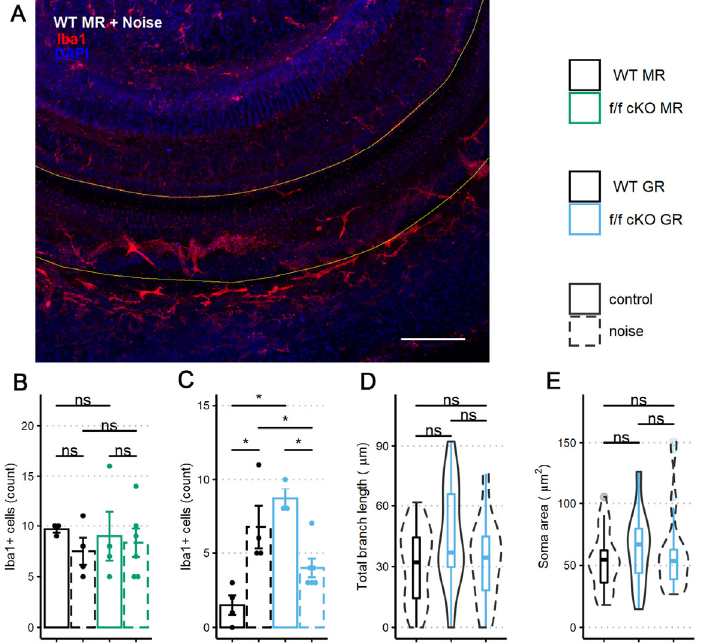
Figure 8. Iba1 + cells within the middle-turn sensory epithelium of mice at 7 dpn and from age-matched controls. ( A ) A representative image of a sensory epithelium wholemount prep from a noise-exposed control (no tamoxifen) fMR:Sox9iCre mouse. ( B ) Iba1 + cell counts per stretch of the middle turn imaged from fMR:Sox9iCre mice. ( C ) Iba1 + cell counts per stretch of the middle turn imaged from fGR:Sox9iCre mice. ( D ) Total branch length of Iba1 + cells within the sensory epithelium. ( E ) Iba1 + cell soma surface area within the sensory epithelium. Scale bar = 100 µ m. Red: Iba1, blue: DAPI. Two-way ANOVA tests were used for statistical assessments of data plotted in B-C and linear mixed effects models were used for data plotted in D-E. Multiple comparisons used the Tukey correction. Significance (*) is p < 0.05 and ns indicates “not